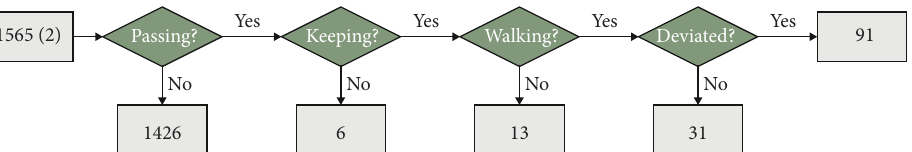
Figure 5: Trajectory filtering processing procedure.